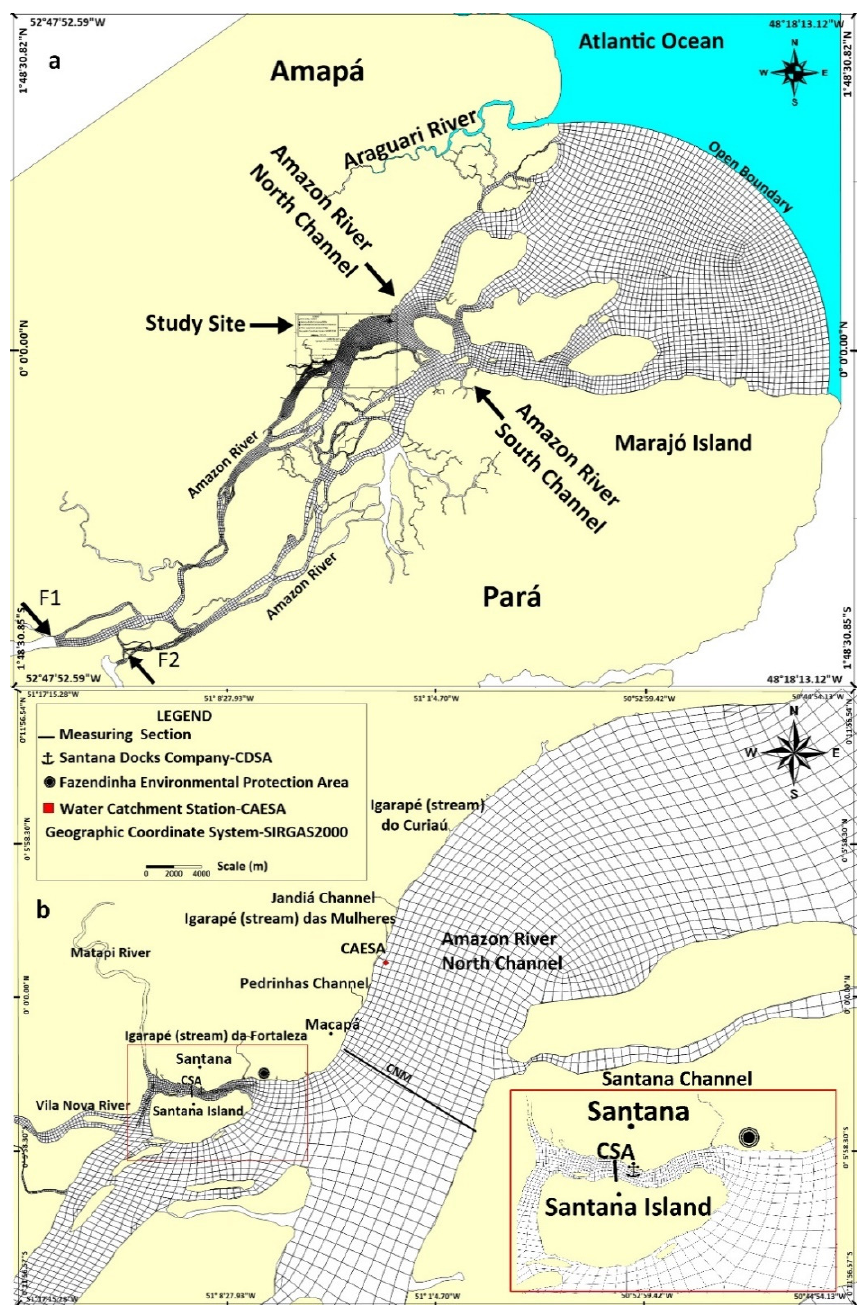
Figure 3. Map showing the computational domain of the study area and location of the boundary conditions imposed in the numerical model: ( a ) wide computer domain ( F1 discharged from the Amazon and Tapajós Rivers; F2 discharged from the Xingu River), and ( b ) highlight of the specific Rt study domainclose to Macapá and Santana. Geographic Coordinate System: Sirgas2000.